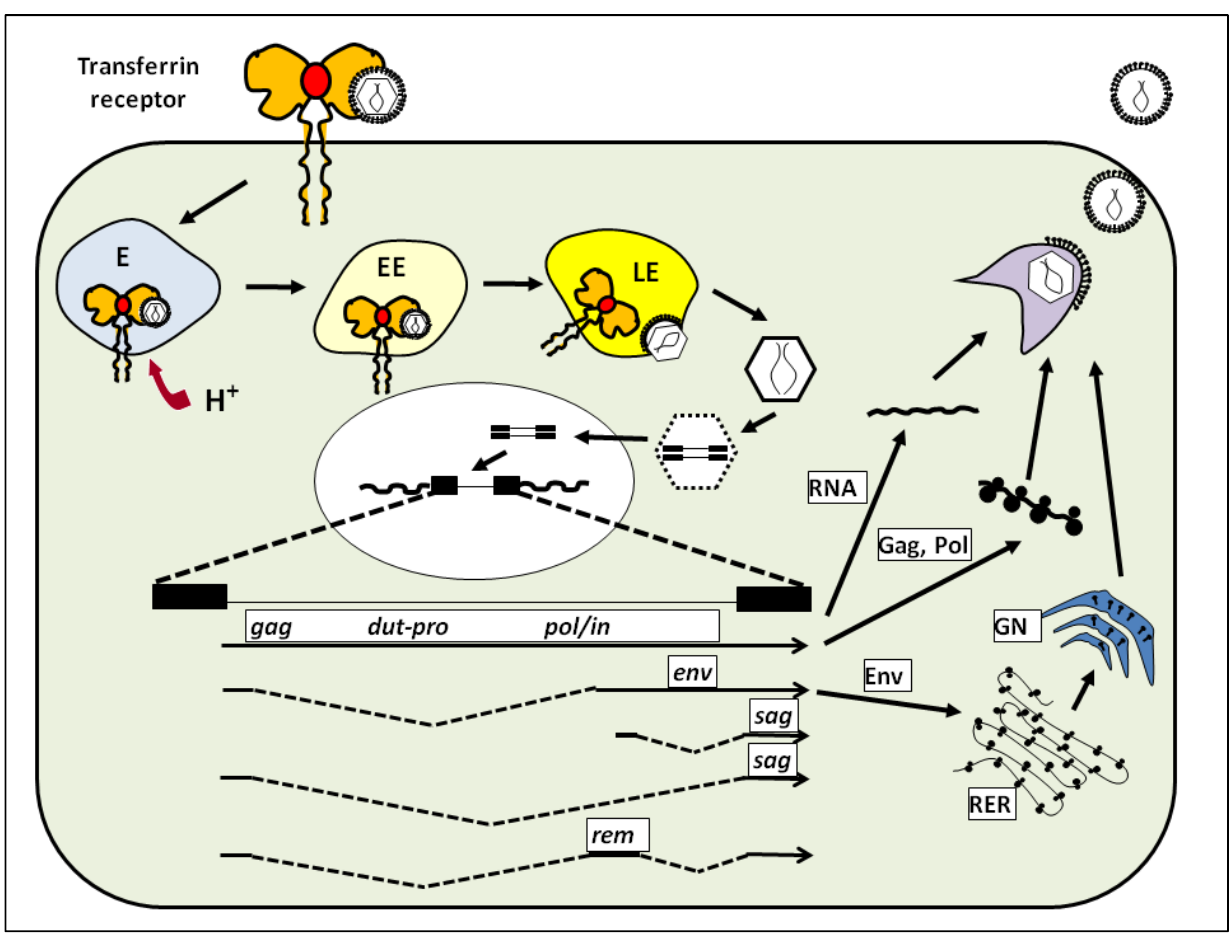
Figure 1 . MMTV infection. MMTV binds to TfR1 on the cell surface and is internalized into a low pH compartment. After uncoating, the viral genome is reverse-transcribed, is transported to the nucleus, and the provirus integrates into the genome. At least five different RNAs are transcribed from the integrated provirus (see text). The Env membrane proteins are synthesis in the rough endoplasmic reticulum (RER) and traffic through the Golgi network (GN). Little is known about MMTV virion assembly, although it occurs in an intra-cellular compartment. Abbreviations: E, endosome; EE, early endosome; LE, late